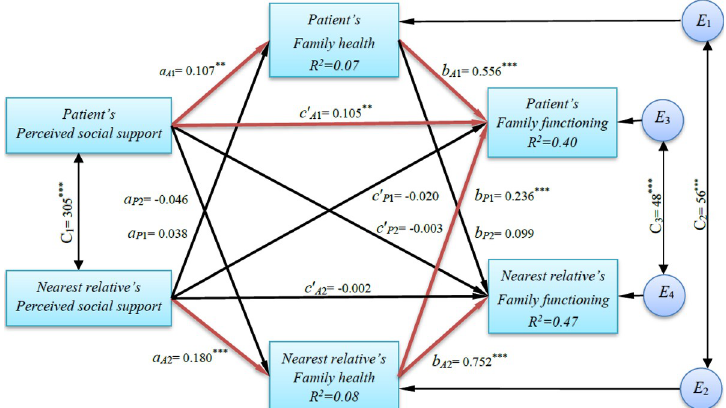
Fig 1. The Actor–Partner Interdependence Mediation Model in patients with heart failure and their nearest relatives. Note. a , direct effect of perceived social support on family health; b , direct effect of family health on family functioning; c 0 , direct effect of perceived social support on family functioning; A , actor effect; P , partner effect; C 1 , covariance between the two predictor variables; C 2 & C 3 , covariance between the two error terms; E 1 , E 2 , E 3 & E 4 , latent error terms; R 2 , coefficient of determination; 1, patient; 2, nearest relative; Estimates are unstandardized regression coefficients; Significant path coefficients are in red. �� p < .01; ��� p < .001.